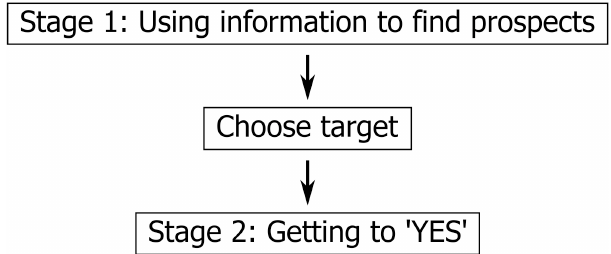
Figure 2. Process of